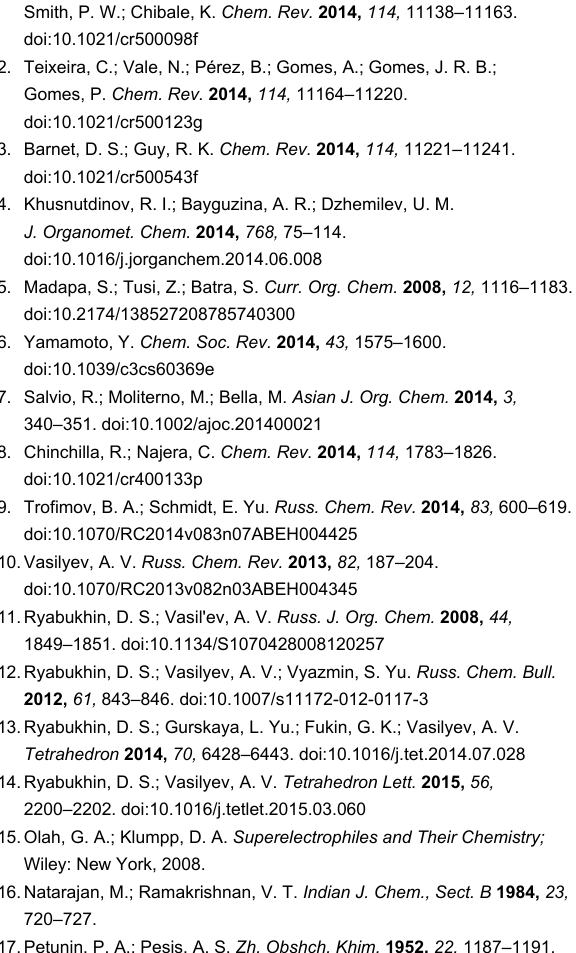
the electrophilicity indices ω of C1 and D1 (Table 2) revealed that the former is stronger electrophile. Also, perhaps, dication D1 was not reactive due to the bigger spatial volume of the methyl substituent in the N -acyl group compared to hydrogen of the N -formyl one in C1 , that hampered the reaction with arene